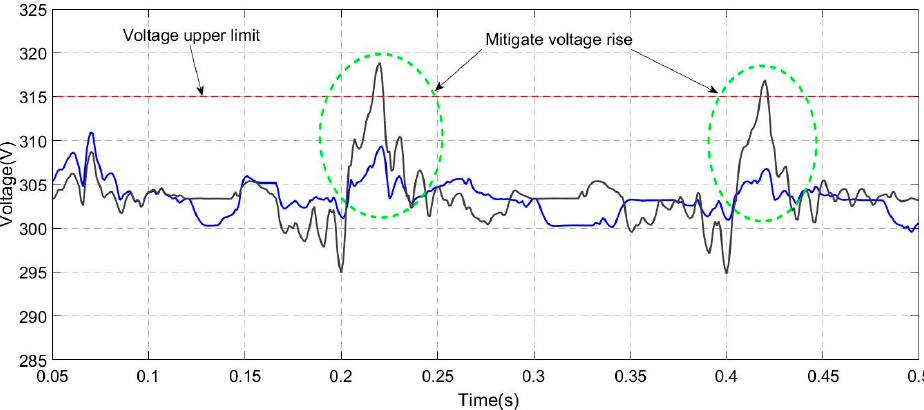
Figure 10. The waveforms of PCC V under power factor control strategy and cloudy control mode. In Figure 11, the gray and blue curves were the waveforms of reactive power consumption under the power factor control strategy and the proposed cloudy control mode.